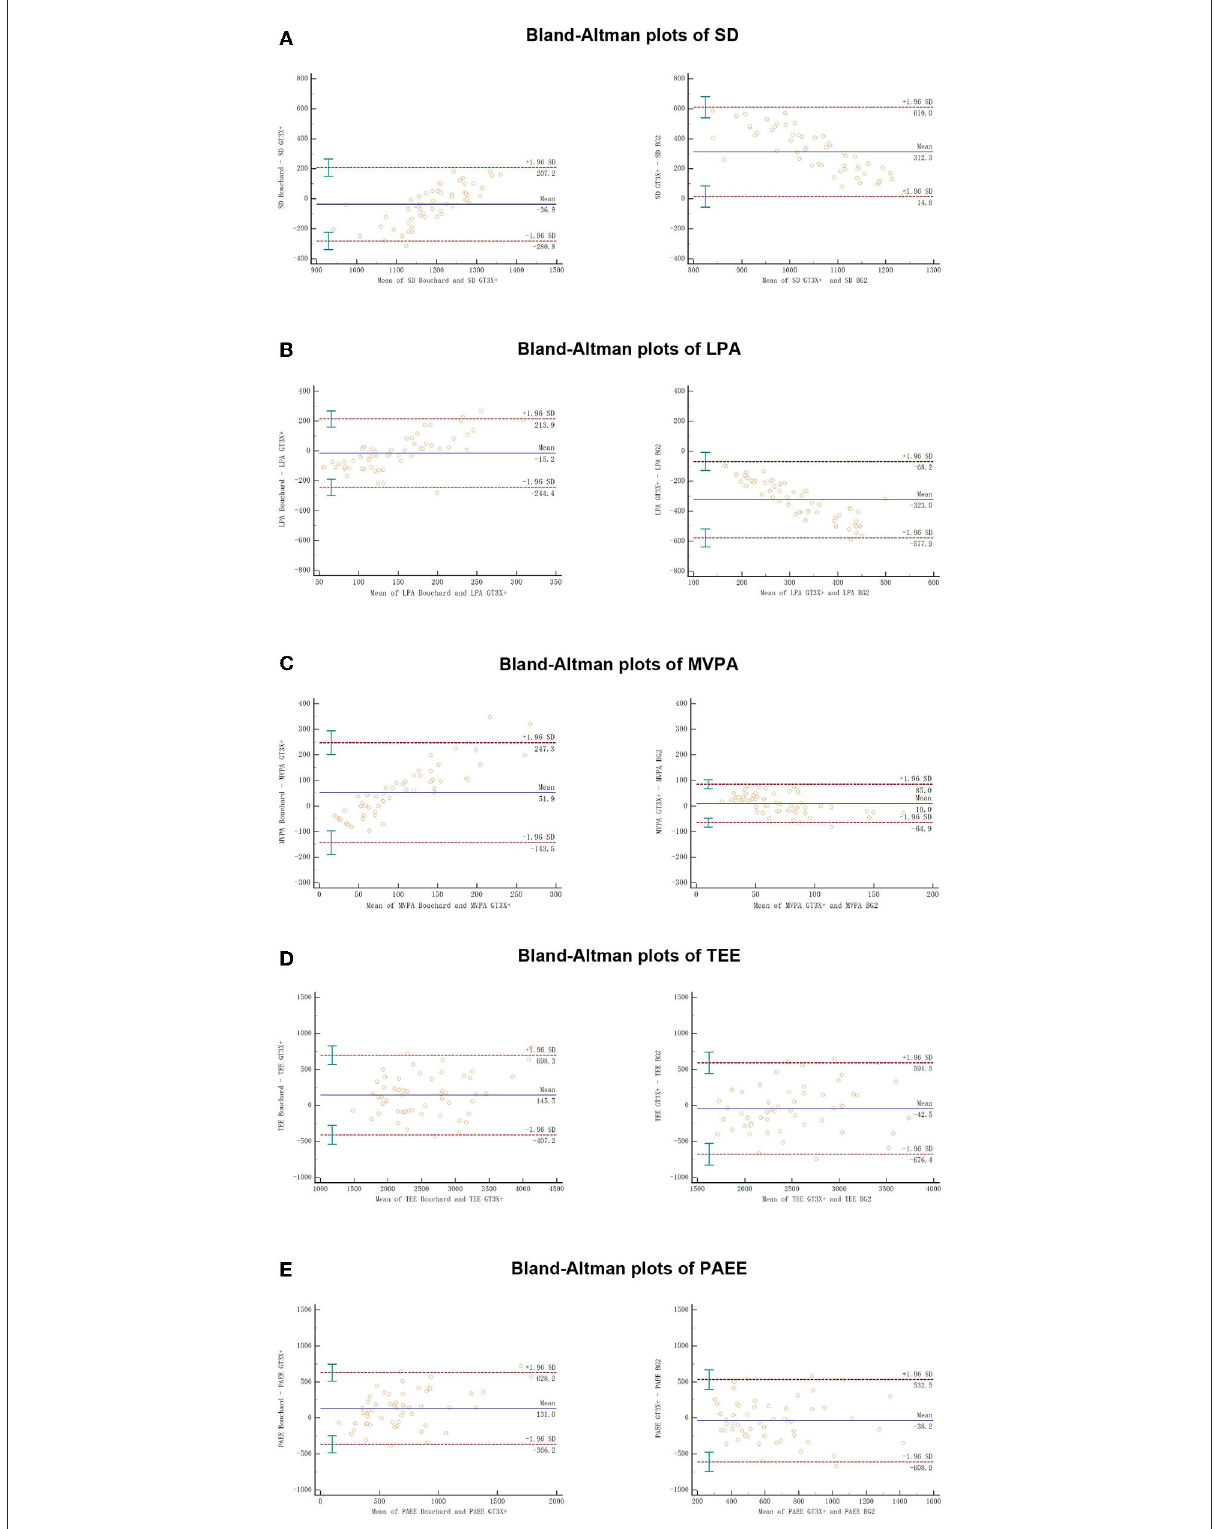
FIGURE3 The Bland–Altman plots for SD, LPA, MVPA, TEE, and PAEE during the free-living by three methods. Solid lines show the mean difference between methods, and dotted lines show the 95% CI of the limits of agreement (Mean ± 1.96 SD); error bars are 95%